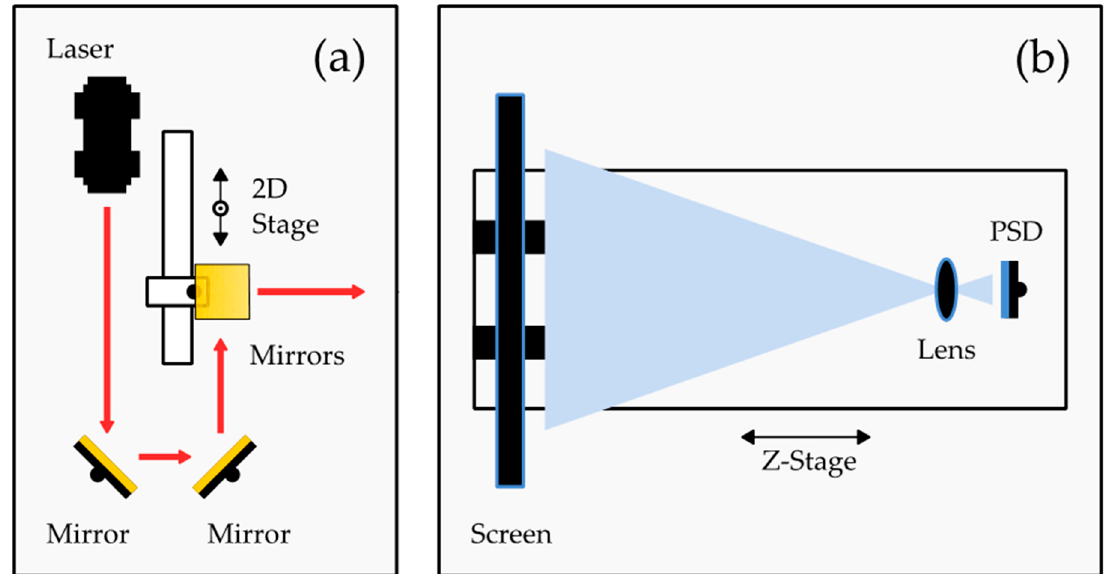
Figure 2. Setup for calibrating the testbench with two translation stages: ( a ) emission path; ( b ) detec- tion